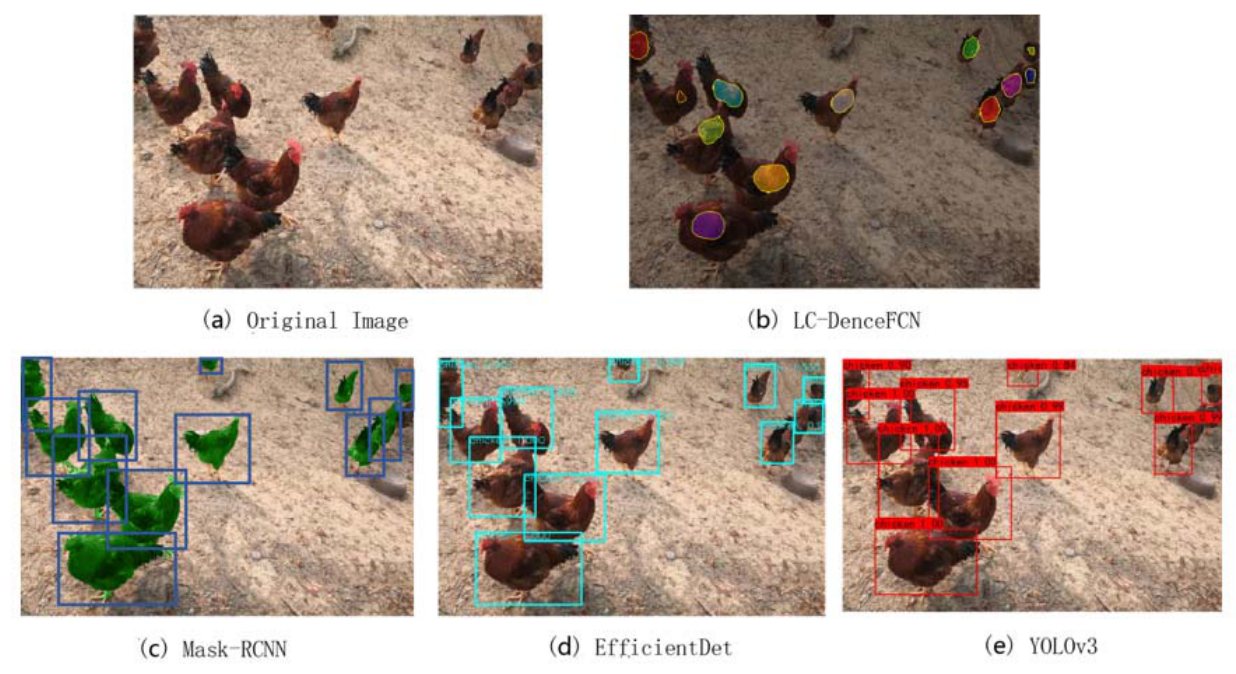
Figure 6. Predictions on the test images for four detection algorithms.